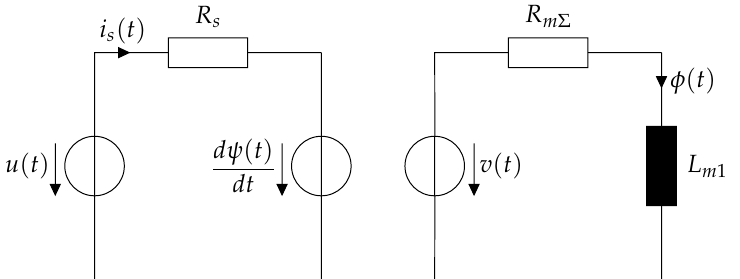
Figure 4. Electromagnetic equivalent circuit of a solenoid actuator considering only the dominant eddy current